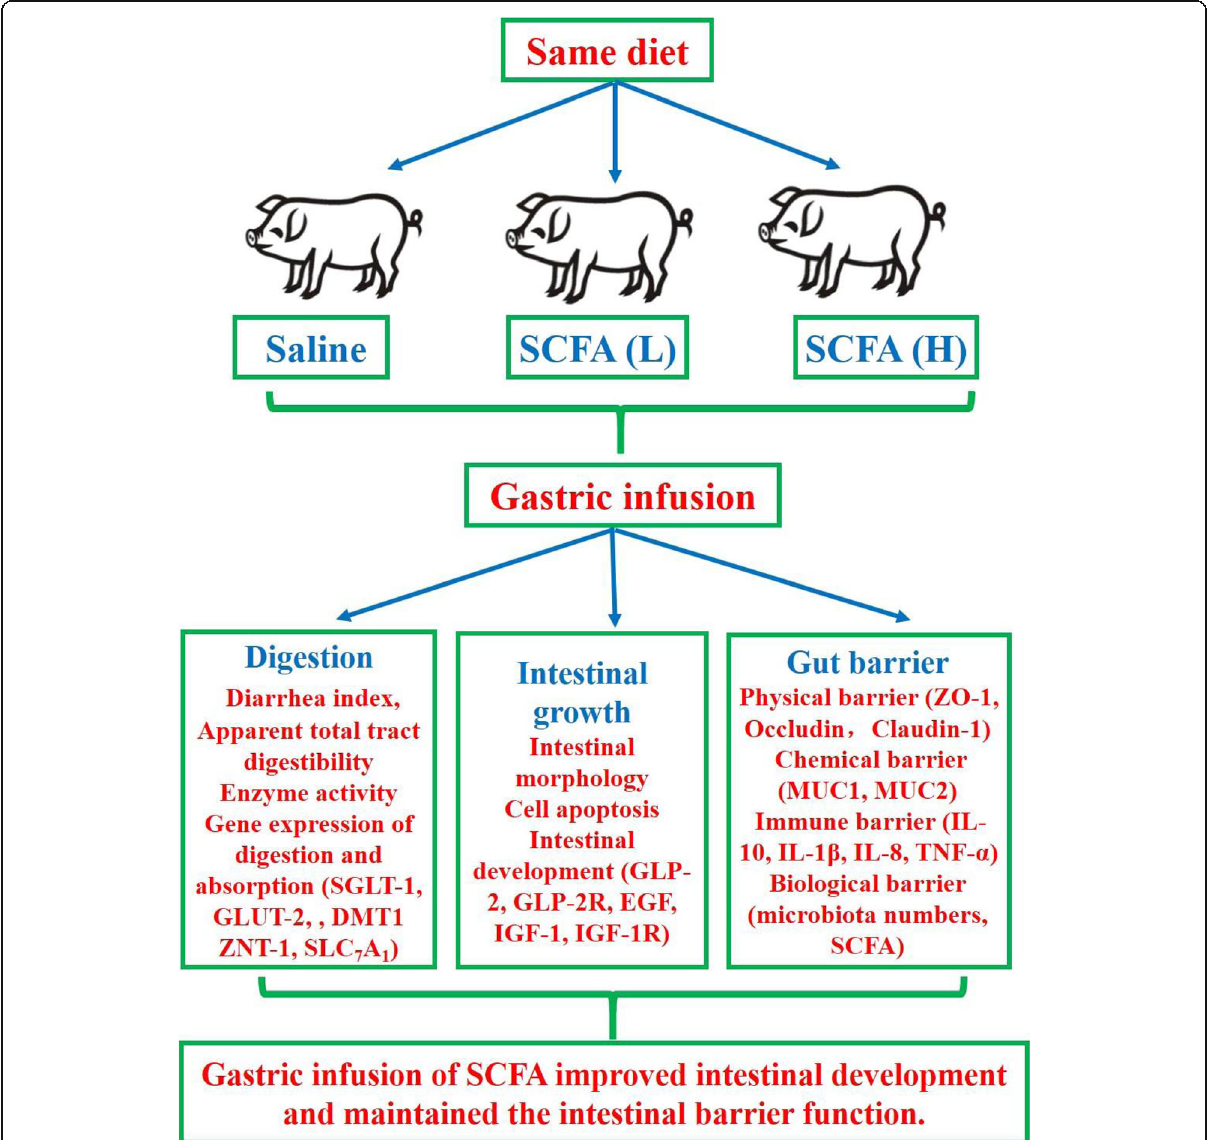
Fig. 9 The overall frame diagram. SCFAs (L), pigs treated with SCFA (acetic, propionic, and butyric acids; 20.04, 7.71, and 4.89 mM respectively); S2, pigs treated with SCFA (acetic, propionic, and butyric acids; 40.08, 15.41, and 9.78 mM